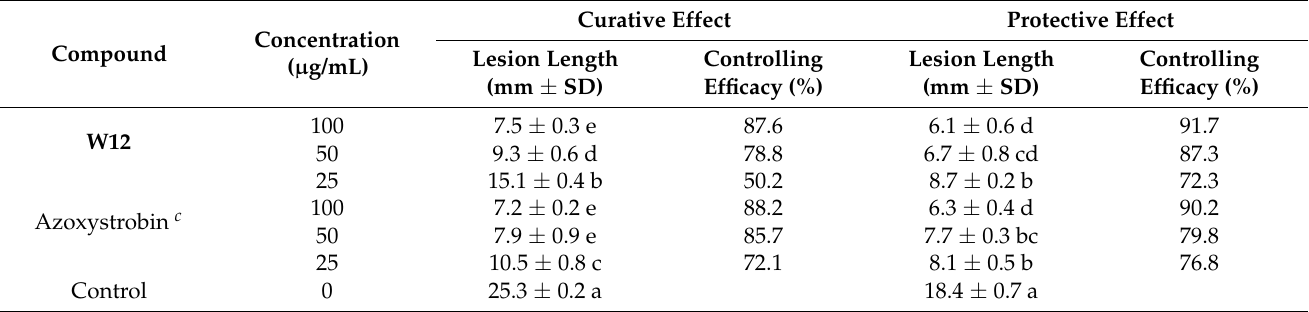
Table 3. Curative and protective activities of W12 against S. sclerotiorum in vivo a b .